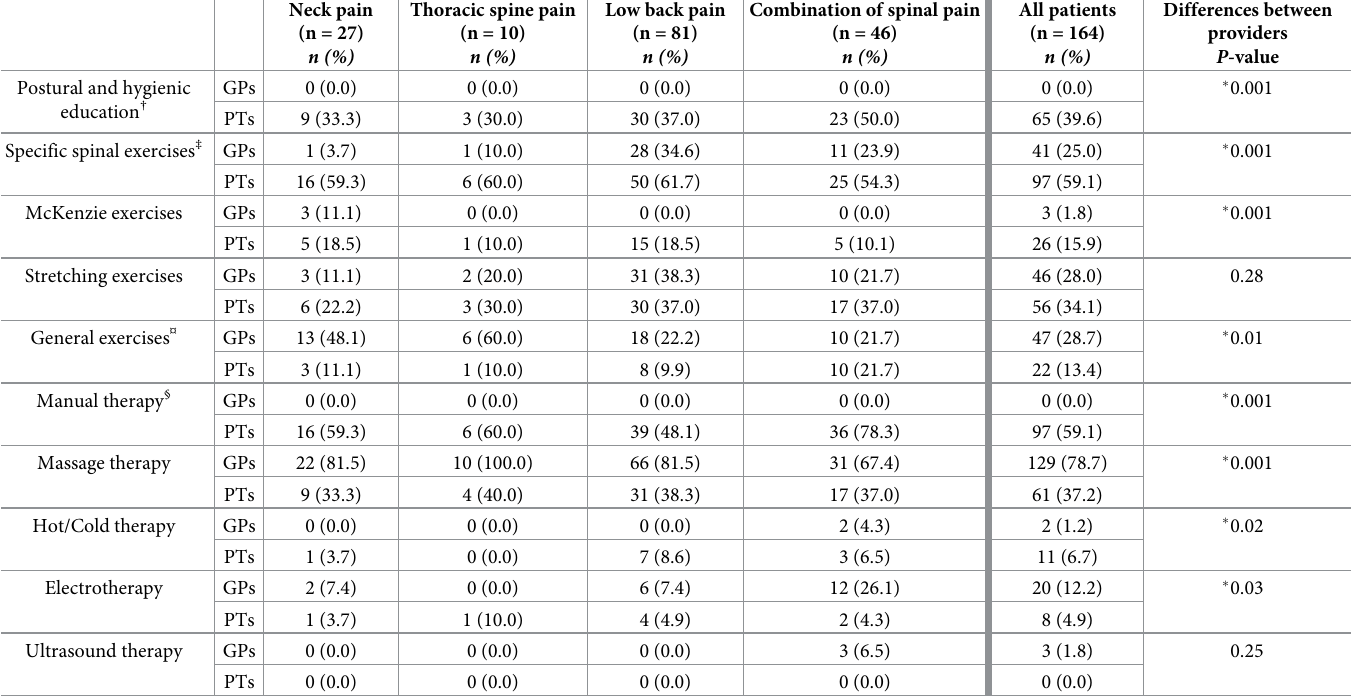
Table 4. Description and differences of specific physiotherapy interventions prescribed by general practitioners based on information provided on the physiother- apy referrals and recommended by physiotherapists at their initial consultation for referred spinal pain patients (n = 164).